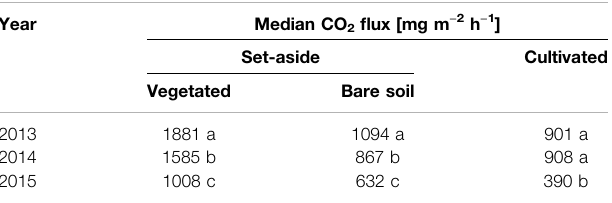
TABLE 7 | Daily ecosystem respiration [mg m − 2 h − 1 ] in July, determined